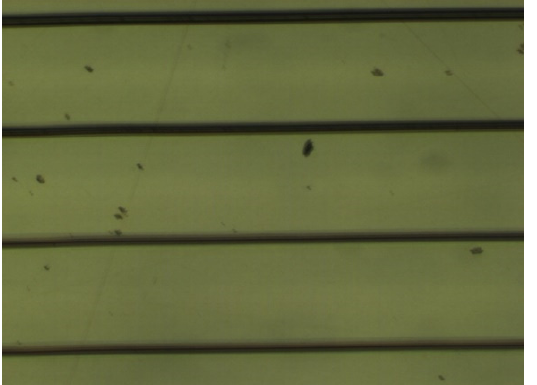
Figure 5. Polarisation microscopic photos of channel waveguides using a microbeam of 11 MeV C 4+ ions at fluences of 2, 1.4, 1.4 and 0.46 · 10 15 ions/cm 2 (from top to bottom). Width of the channel waveguides is 15 μ m.